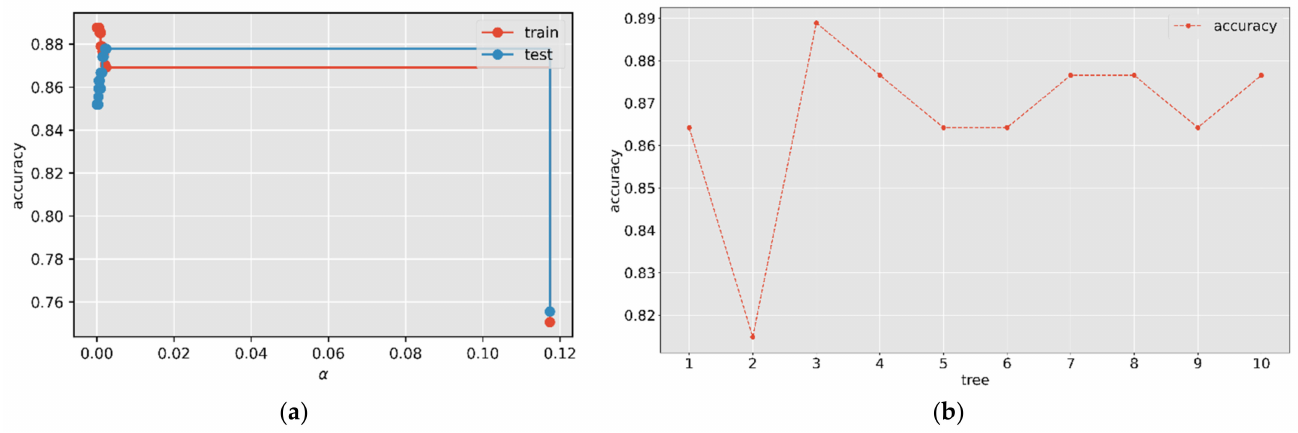
Figure 4. Accuracy versus pruning parameter ( α ) ( a ) and accuracy for fitting 10 trees using 10 subsets ( b ).